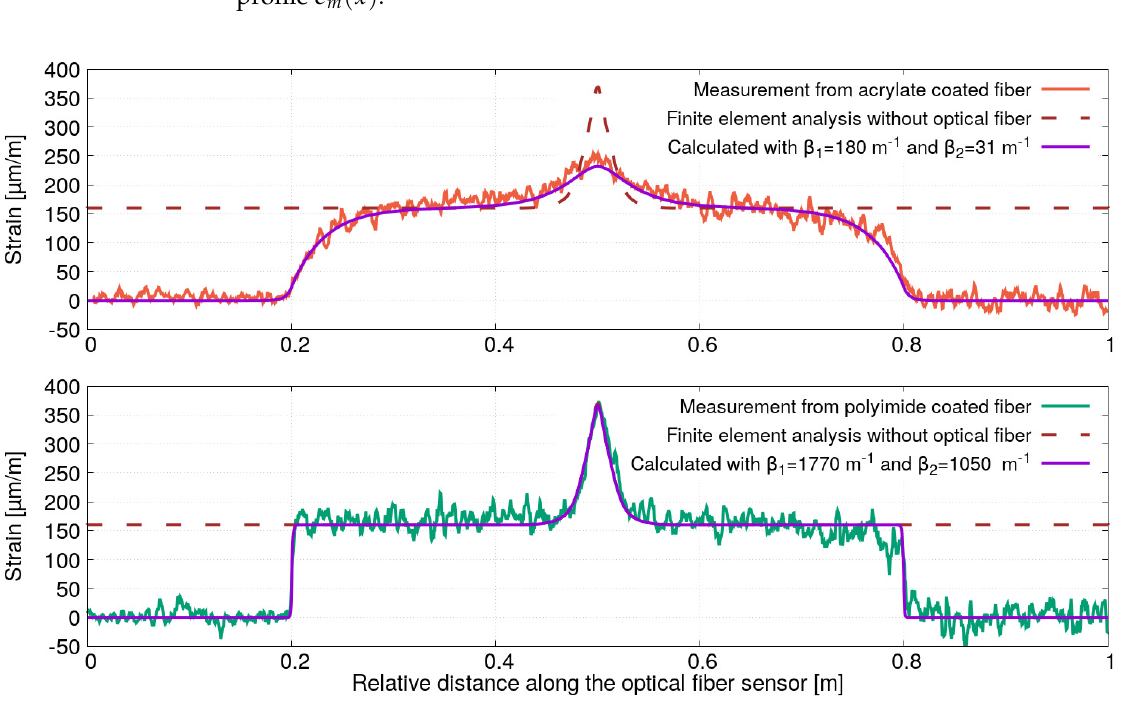
Figure 15. Comparisons of strain profile measured and calculated for the optical fibers with polyimide and acrylate